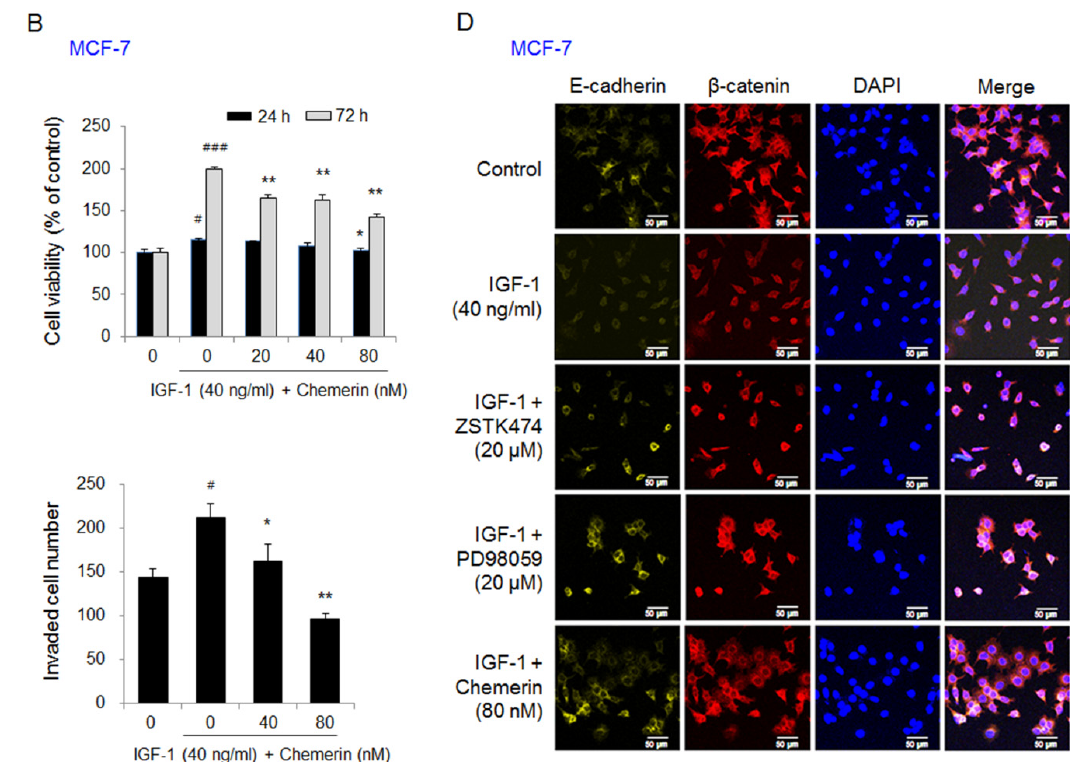
Figure3. Chemerinsuppressedtheviability,invasion,andEMTofinsulin-likegrowthfactor(IGF)-1-treated breast cancer cells. ( A , B ) The viability and invasion of ( A ) MDA-MB-231 or ( B ) MCF-7 cells treated with IGF-1 and chemerin for 24 and 72 h. Cell viability was measured by an MTT assay. Cell invasion was determined by counting the number of invaded MDA-MB-231 and MCF-7 cells 24 h after IGF-1 and chemerin treatment using a Transwell chamber; ( C , D ) The expression levels and cellular localization of E-cadherin and β -catenin in MDA-MB-231 or MCF-7 cells treated with chemerin, ZSTK474 (PI3K inhibitor), or PD98059 (MEK1 / 2 inhibitor) in the presence of IGF-1. The cells were immunostained with specific primary antibodies against β -catenin or E-cadherin and then with Alexa Fluor 488 goat anti-mouse IgG or Alexa Fluor 594 goat anti-rabbit IgG. The slides were mounted using Vectashield mounting medium with DAPI. The images were collected using a Zeiss LSM 700 confocal microscope. Representative immunofluorescence images. Scale bar, 20 µ m in MDA-MB-231 cells and 50 µ m in MCF-7 cells. Data are expressed as the mean ± SEM. # p < 0.05, ## p < 0.01, ### p < 0.001 versus cells without IGF-1 and chemerin, * p < 0.05, ** p < 0.01 versus cells treated with IGF-1